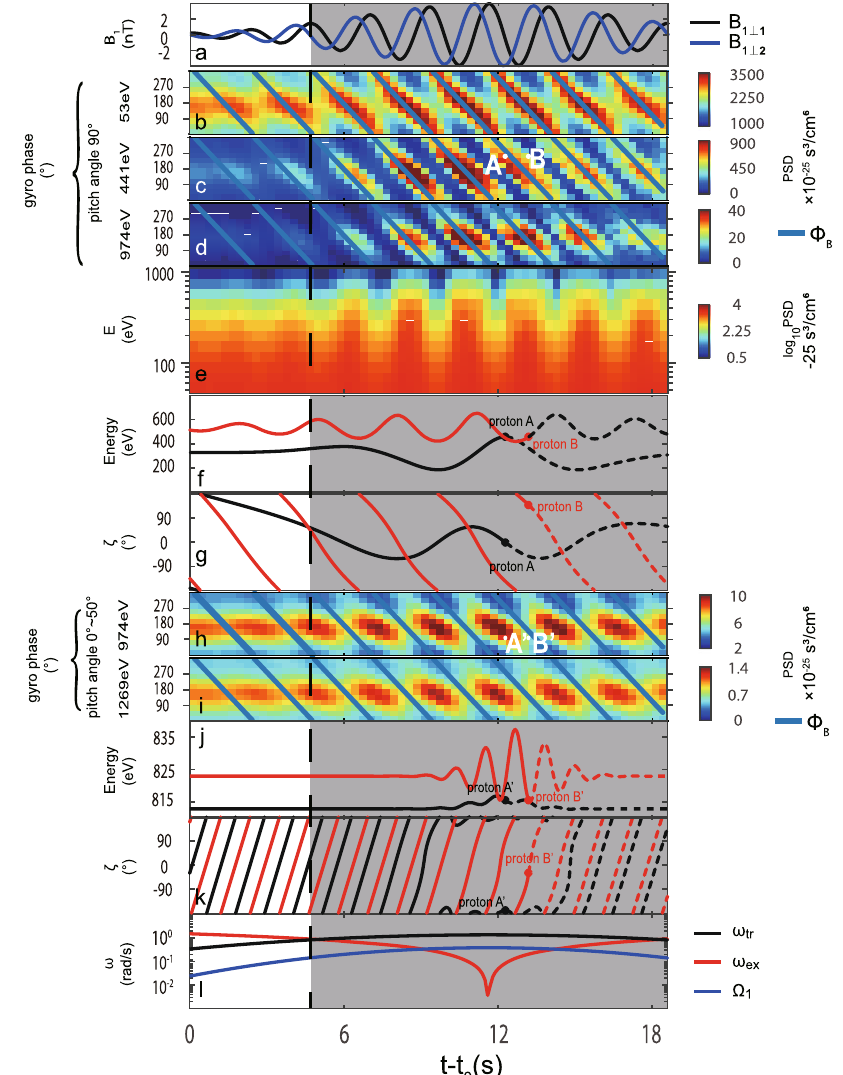
Fig. 2 Simulation results observed by the virtual spacecraft. a Wave magnetic fi eld, with the ⊥ 1 and ⊥ 2 components indicated by the black and blue lines, respectively. b – d Gyro-phase spectra in the same format as in Fig. 1g – i. e Energy spectrum in the same format as in Fig. 1j. f , g Temporal variations of kinetic energy and ζ (phase difference between the particle perpendicular velocity and the wave magnetic fi eld) for sample protons A (black) and B (red), with their fi nal energy and pitch angle (when reaching the spacecraft) labeled in Fig. 2d. The dashed lines represent the variations after their spacecraft arrival. h , i Gyro-phase spectra in the same format as in Fig. 1k – l. j , k Temporal variations of kinetic energy and ζ for sample protons A ′ (black) and B ′ (red), in the same format as in ( f , g ). l Temporal variations of the particle trapping frequency ( ω tr , black), resonance island expansion rate ( ω ex , red) and nominal gyrofrequency ( Ω 1 , blue) associated with the wave fi eld B 1 , calculated based on the typical proton with 441 eV energy and 90° pitch